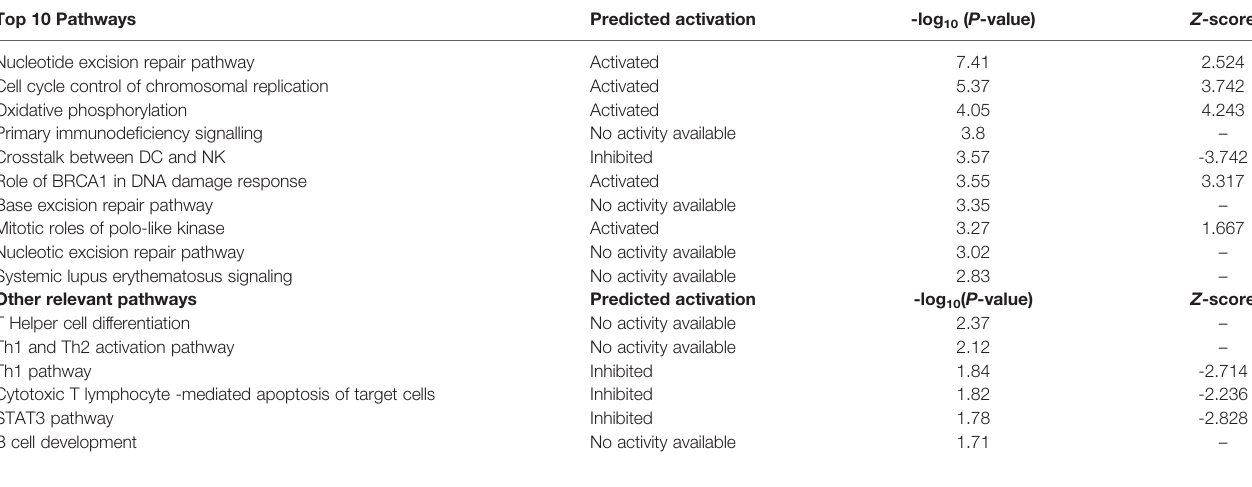
TABLE 2 | Top 10 canonical pathways and other signi fi cant immune response related pathways. Top 10 Pathways